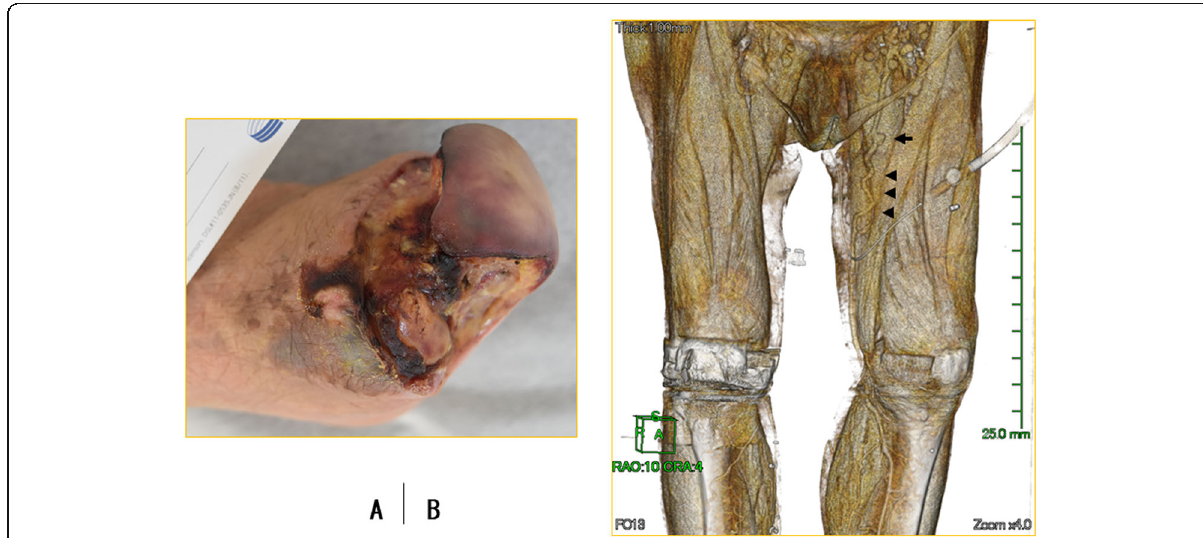
Fig. 2 The stump became gradually necrotic after metatarsal amputation ( a ). Preoperative plain computed tomography showed that the left great saphenous vein was complicated with varicose veins (arrowheads) with thin vessel walls (arrow) ( b